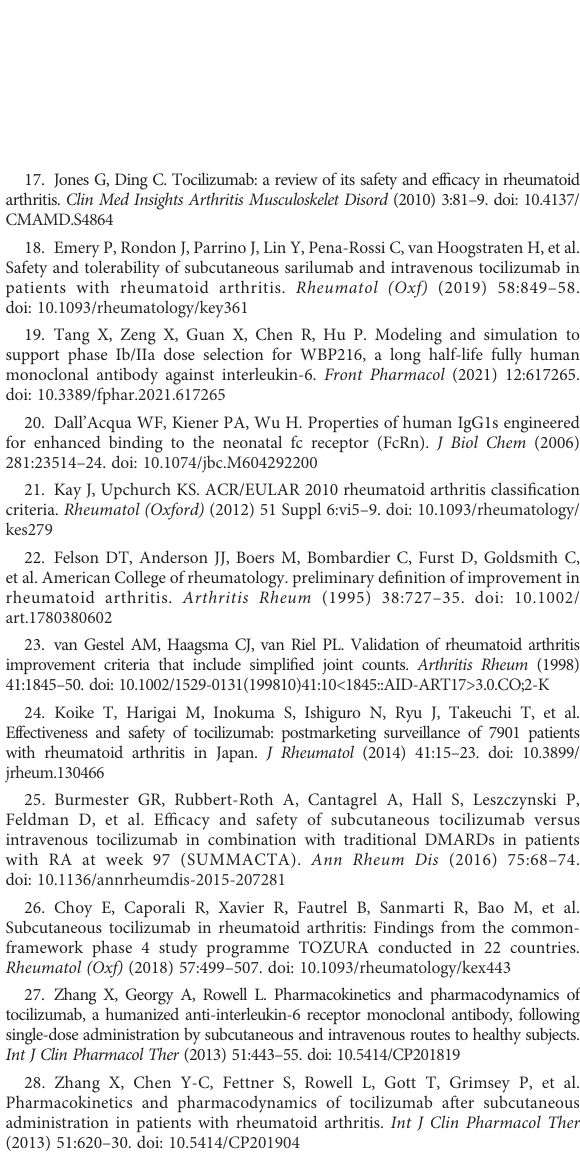
SUPPLEMENTARY TABLE 1 Medical history, prior and concomitant